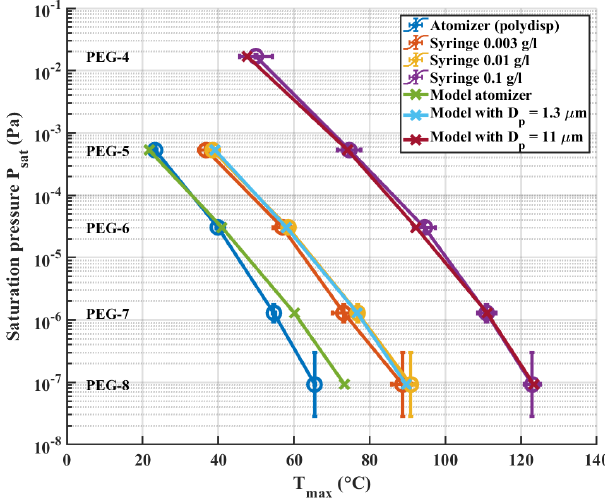
Figure 4. Comparison of the solution concentration effect on PEG results with model results. Error bars in T max values are SDs of three